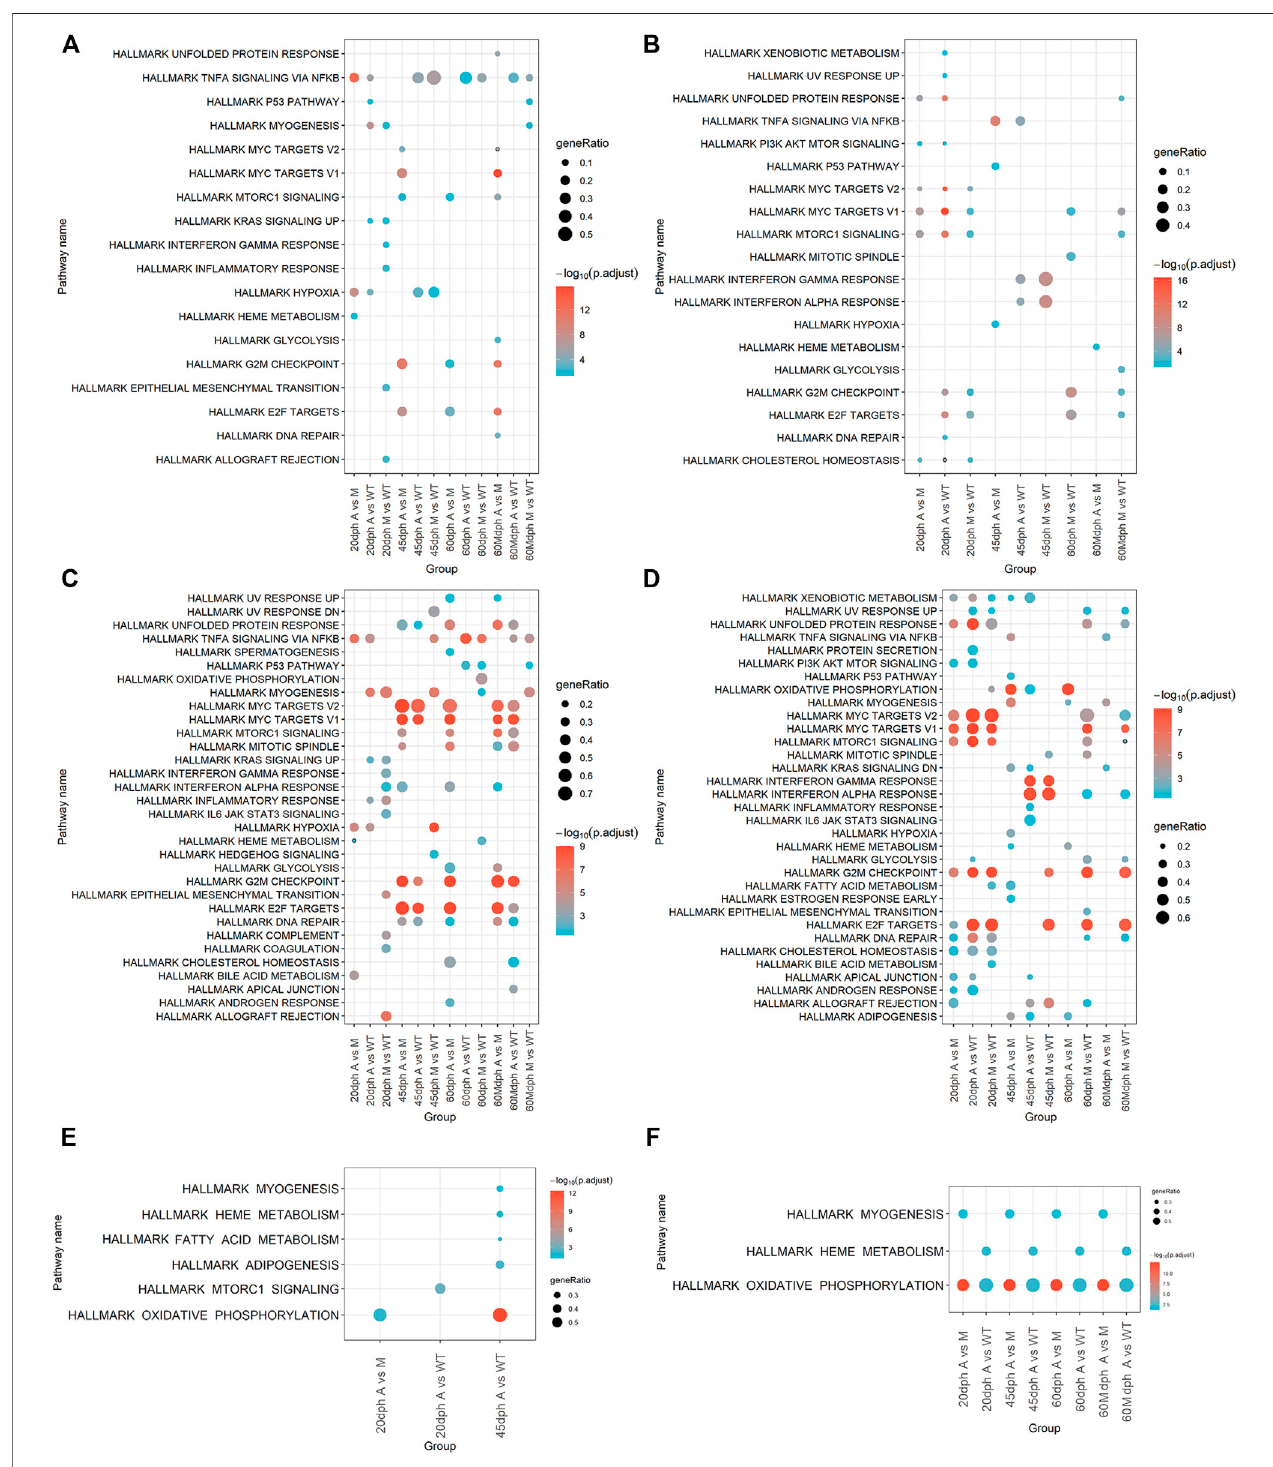
FIGURE5| Pathwaysenriched byDEGsandtargetgenesofDEmiRNAs. (A) Pathwaysenriched inupregulated genesbetweengroups. (B) Pathwaysenriched in downregulatedDEGsbetweengroups. (C) ActivatedpathwaysanalyzedbyGSEA. (D) SuppressedpathwaysanalyzedbyGSEA. (E) Pathwaysenrichedintargetgenes of upregulated miRNAs between groups. (F) Pathways enriched in target genes of downregulated miRNAs between groups. Target genes were predicted by TargetScan and miRanda and had a signi fi cantly negative correlation ( p < 0.05) with DE miRNAs.